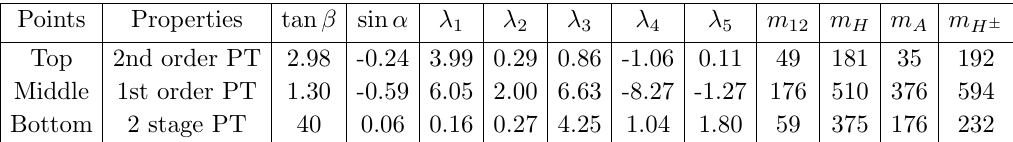
Table 3 . Parameters for three benchmark points (with all mass parameters in units of GeV) that lead to di(cid:11)erent types of